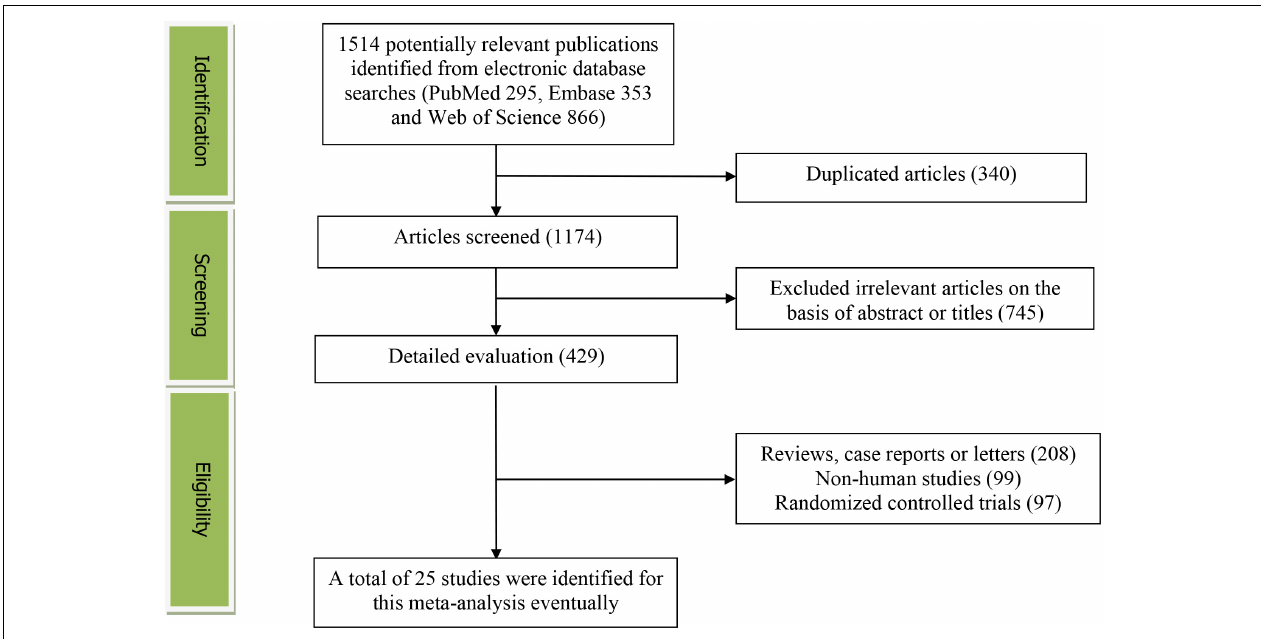
FIGURE 1 | The detailed flow diagram of the study identification and selection in this